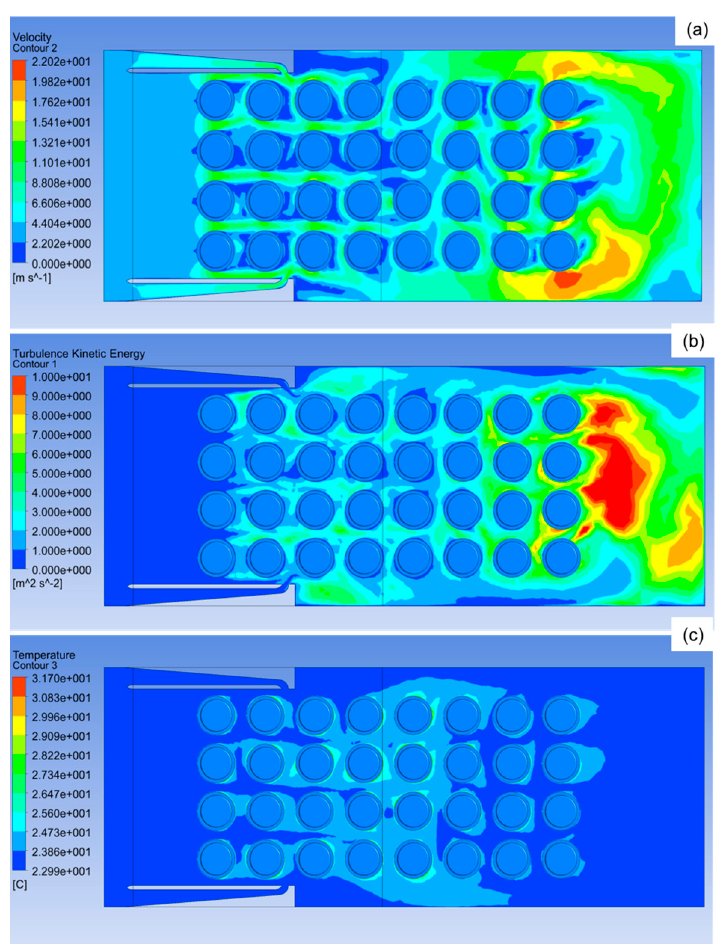
Figure 8. Contours of ( a ) velocity, ( b ) turbulence kinetic energy, and ( c ) temperature in the horizontal plane at 52 mm from the bottom of the battery pack for Case